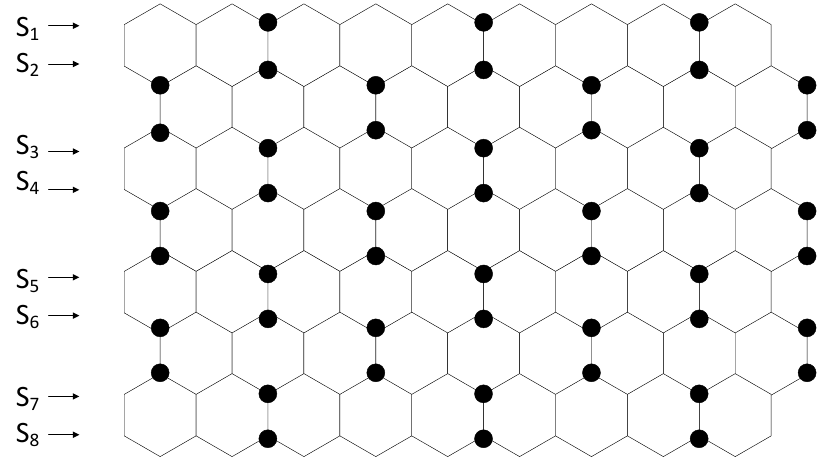
Figure 2. S 1 ∪ S 2 ∪ · · · ∪ S 8 on H 9,7